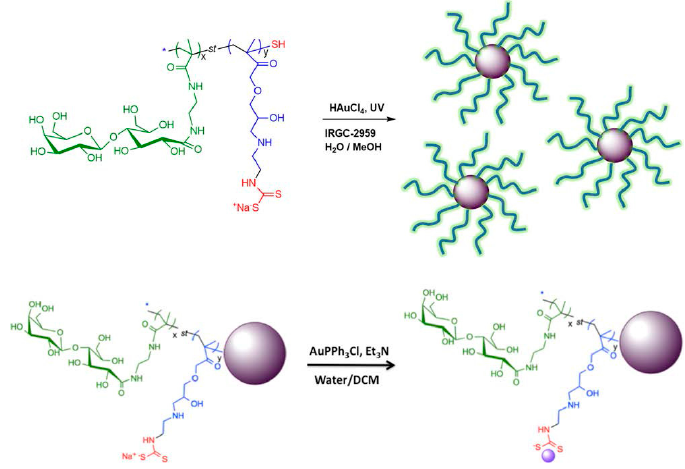
Figure 4. Synthesis of polymer functionalized gold nanoparticles and their conjugation to the anticancer drug Au(1)PPh3 [104].